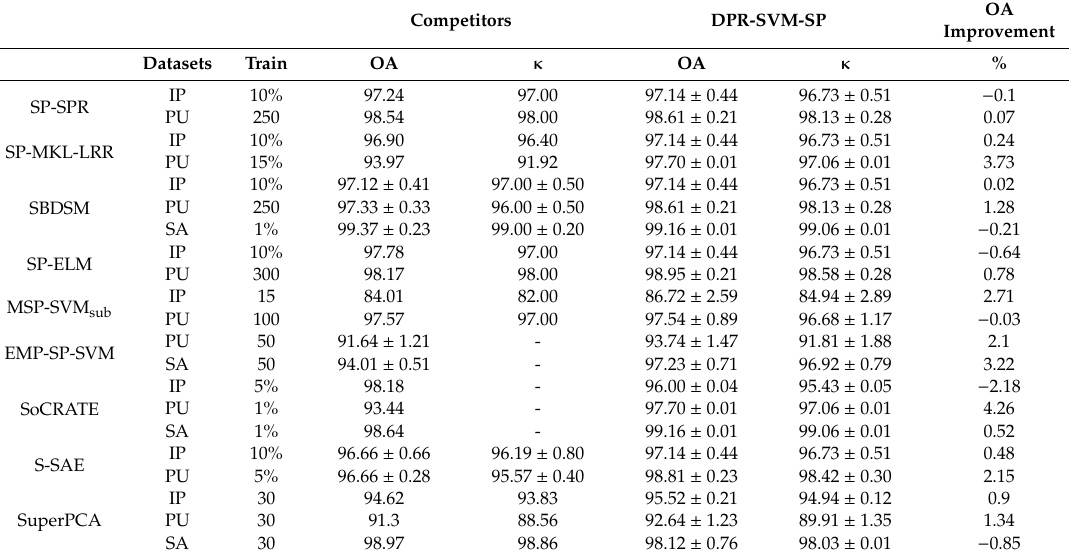
Table 5. Comparison with other nine competitive methods on Indian Pines (IP), Pavia University (PU) and Salinas (SA) datasets. Train denotes the number of training samples per class (ratio or fixed